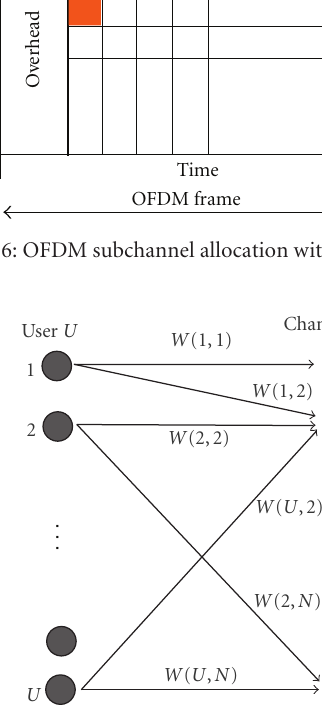
Figure 7: Bipartite graph with users and channels as nodes of the